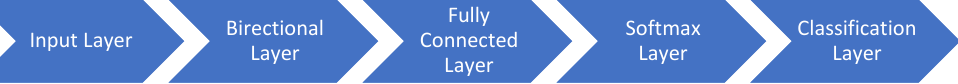
Figure 6. LSTM Layers Architecture.